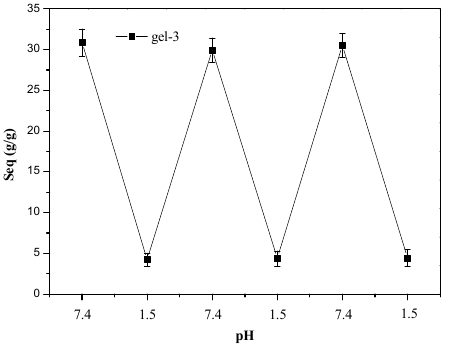
Figure 2. Reversible swelling–deswelling behavior of gel-3 in the buffer solutions with pH 1.5 and 7.4 at 37 °C.